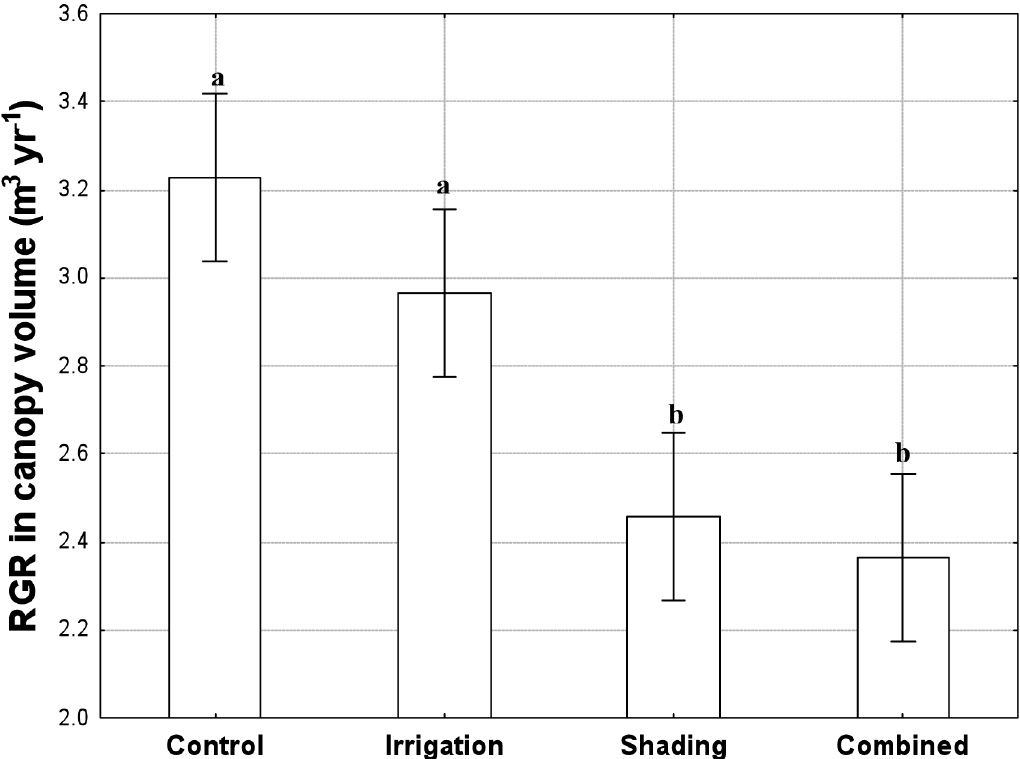
Fig. 2. Relative growth rate in canopy volume of planted Q. ilex trees during the post-treatment period after being previously treated by a combination of summer irrigation and artificial shading for three years. Different letters indicate statistical differences at p = 0.05 according to a Tukey´s test. Bars denote 95% confidence